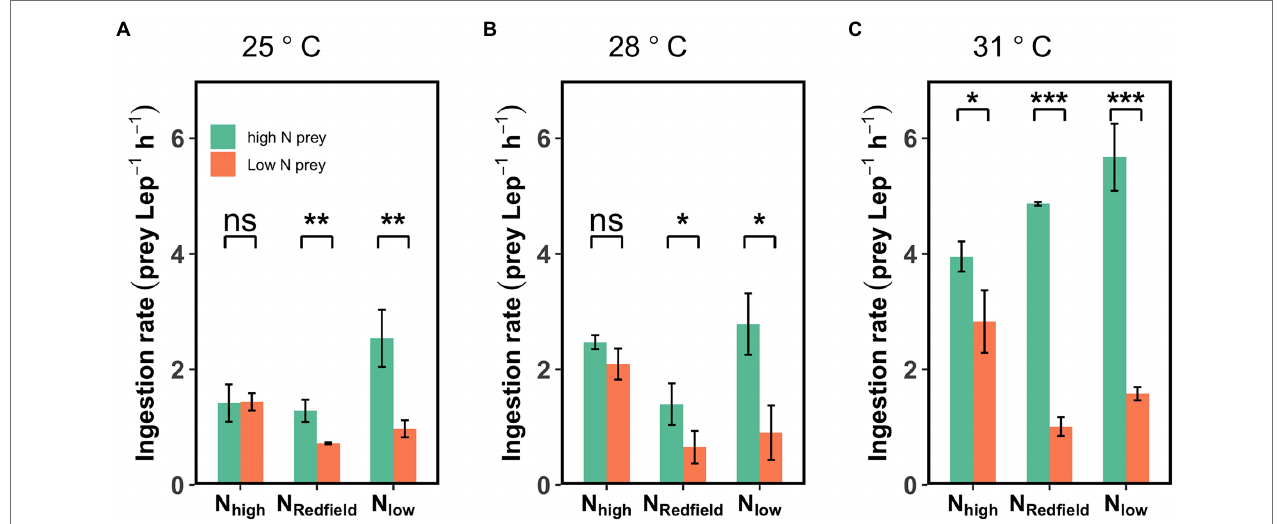
FIGURE 3 | Ingestion rate of Lepidodinium sp. on high-N prey and low-N prey under three different nutrient treatments (N high , N Redfield and N low ) at 25 ° C (A) , 28 ° C (B) and 31 ° C (C) . The asterisk indicates the significant difference between high-N prey and low-N prey (Tukey HSD Test following a one-way ANOVA; * p < 0.05; ** p < 0.01; *** p < 0.001; and ns: p > 0.05).